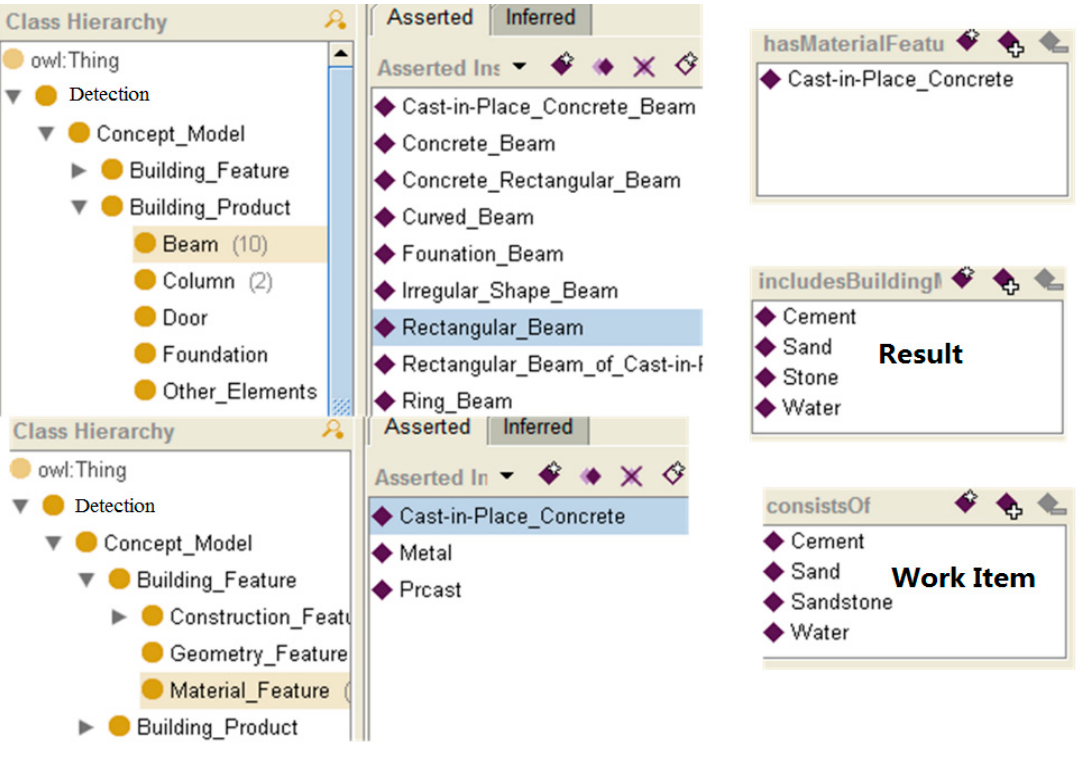
Figure 17. Inference result.